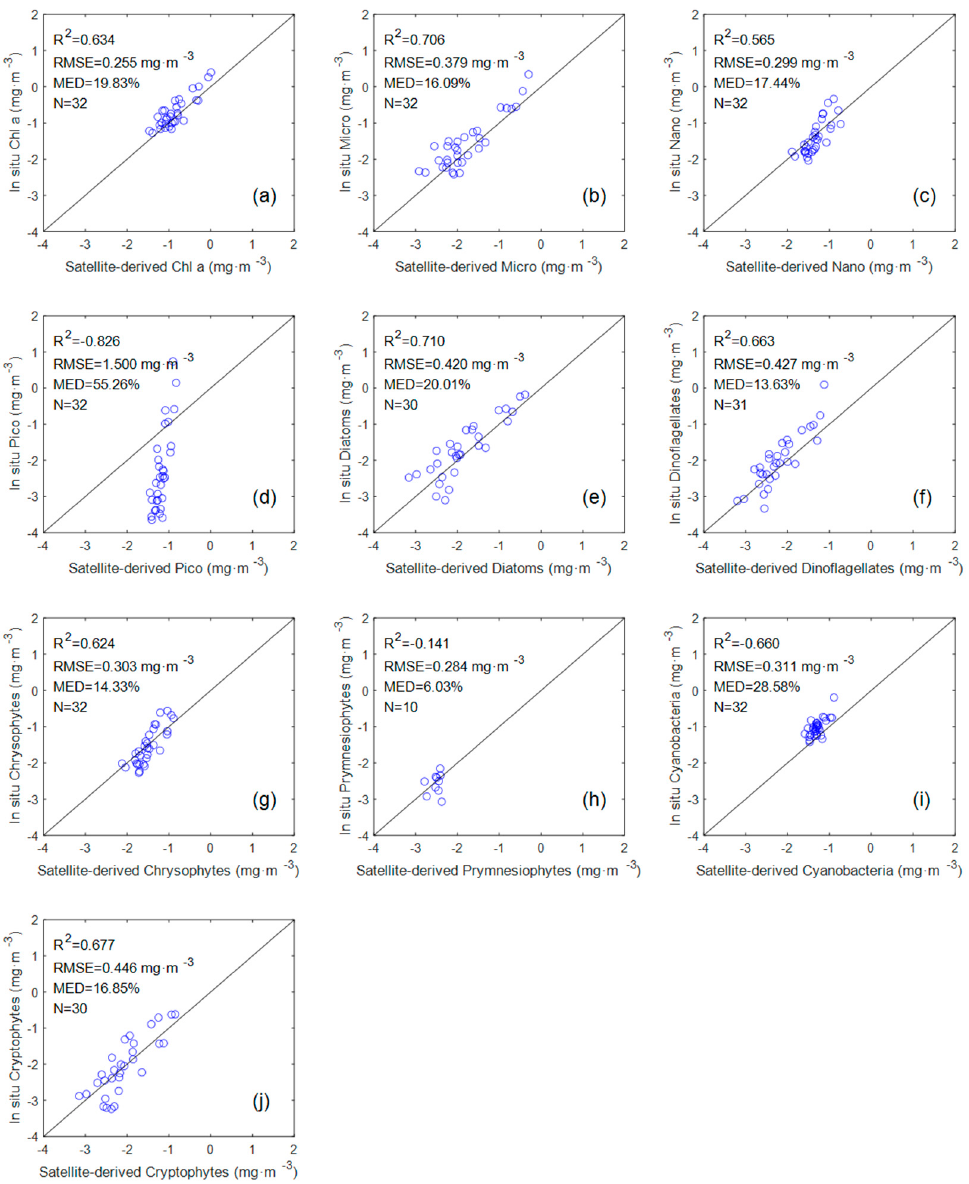
Figure 6. Scatter plots of the in situ groups versus satellite-derived groups: ( a ) Chl a; ( b ) Micro; ( c ) Nano; ( d ) Pico; ( e ) diatoms; ( f ) dinoflagellates; ( g ) chrysophytes; ( h ) prymnesiophytes; ( i ) cyanobac- teria; ( j ) cryptophytes. The solid line is the 1:1 line. The N is the number of samples.